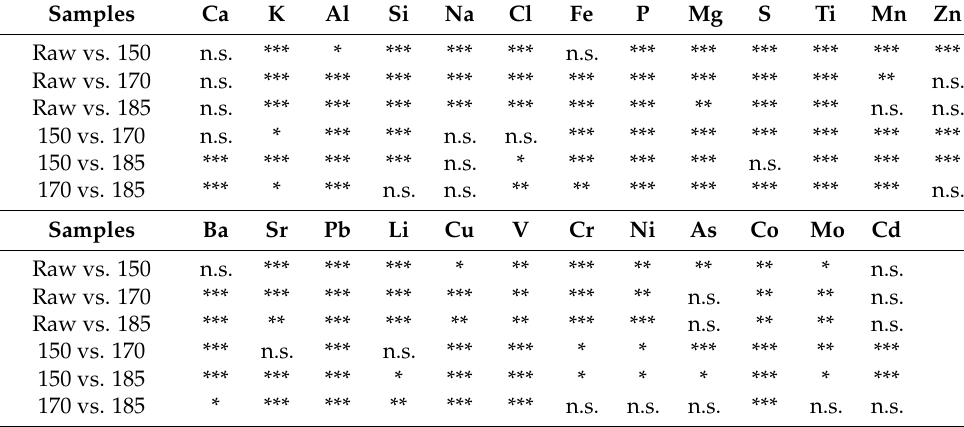
Figure 4. Mean values ± standard deviation of raw and treated (biochars) organic fraction of municipal solid waste (OFMSW) for elements with concentrations between 10 and 1000 mg/kg dry matter (DM) and with concentrations < 10 mg/kg DM (right upper diagram). Legal limits for fuels according to prEN ISO 17225-8:2016 [46] and the German Biowaste Ordinance [5] are included. Table 3. Level of significance for the influence of hydrothermal treatment on element contents in raw and treated organic fractions of municipal solid waste (OFMSW). Comparison of raw OFMSW with OFMSW treated at 150, 170 and 185 ◦ C (biochars). Not significant (n.s.), * ( p < 0.05), ** ( p < 0.01), *** ( p < 0.001). Samples Ca K Al Si Na Cl Fe P Mg S Ti Mn Zn Raw vs. 150 n.s. *** n.s. Raw vs. 170 n.s. n.s. Raw vs. 185 n.s. n.s. 150 vs. 170 n.s. 150 vs. 185 170 vs. 185 n.s. *** n.s. Samples Ba Sr Pb Li Cu V Cr Ni As Co Mo Cd Raw vs. 150 n.s. *** *** *** * ** *** ** ** ** * n.s. Raw vs. 170 *** *** *** *** *** ** *** ** n.s. ** ** n.s. Raw vs. 185 *** ** *** *** ** ** *** *** n.s. ** ** n.s. 150 vs. 170 *** n.s. *** n.s. *** 150 vs. 185 170 vs.